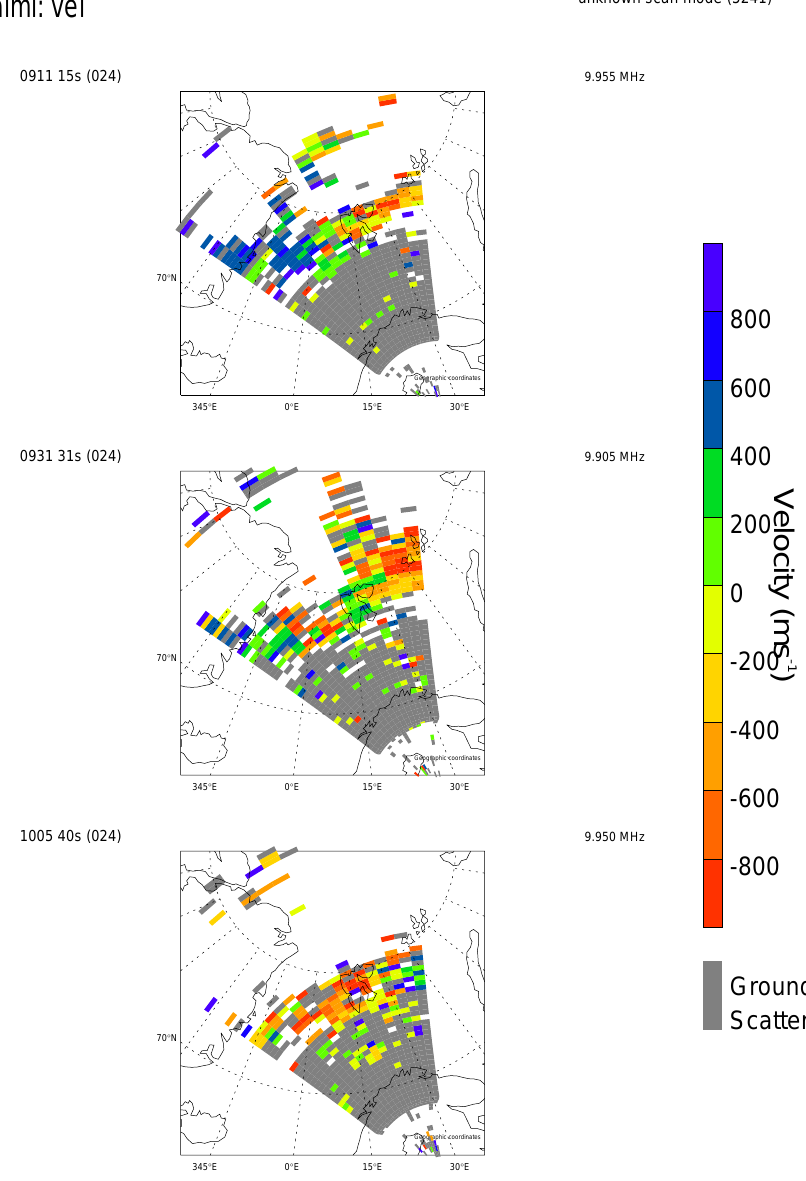
Fig. 5. Representative line-of-sight plasma flow velocities measured by the Finland CUTLASS SuperDARN radar at selected times during the time interval of